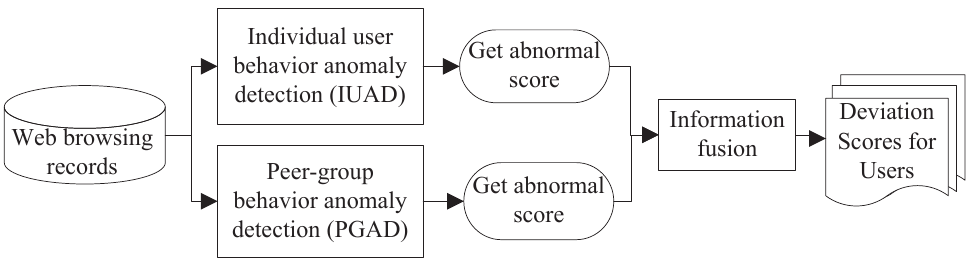
Figure 1. The proposed fusion framework for insider threat detection.